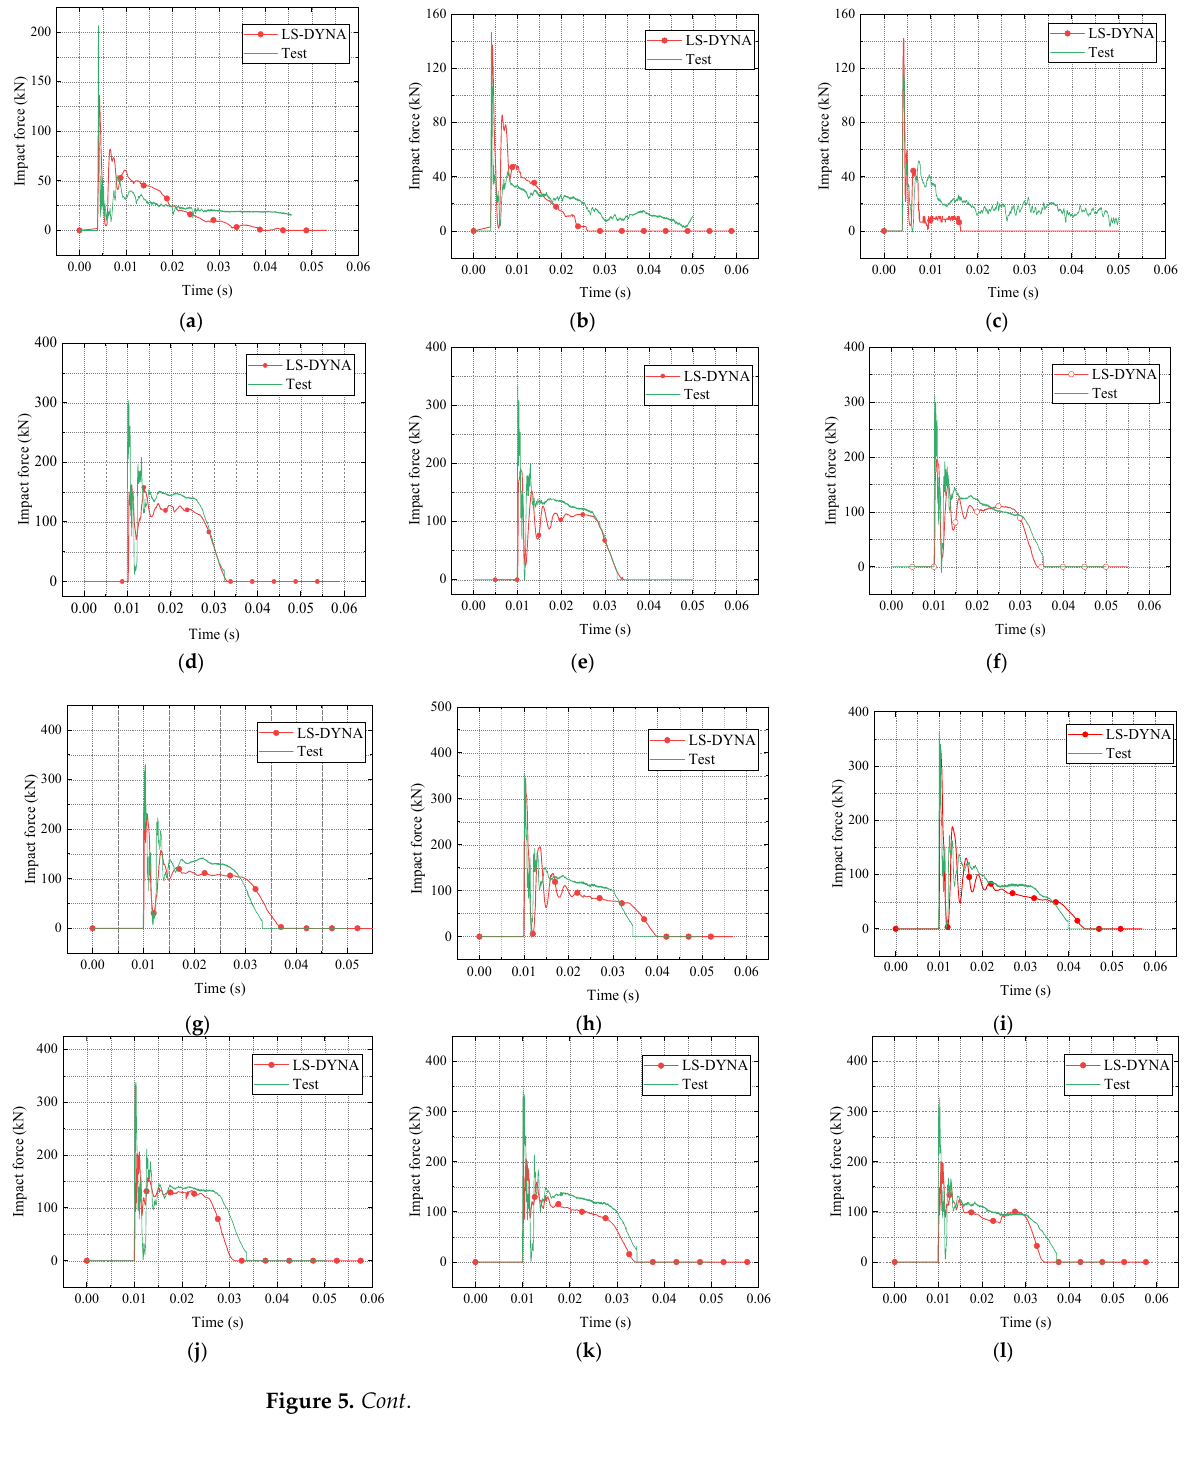
Figure 4. Comparison of observation and prediction of typical failure modes of RC columns and composite columns. ( A ) Observed in the test and ( B ) Predicted in FEA Figure 5 shows the comparison between the predicted and measured impact force– time histories of five composite column specimens. It can be seen that, except for the RC column, all composite sections fit well with the test results. This is because the RC column suffered severe impact damage and the CSCM concrete material model of LS-DYNA cannot accurately simulate concrete damage.